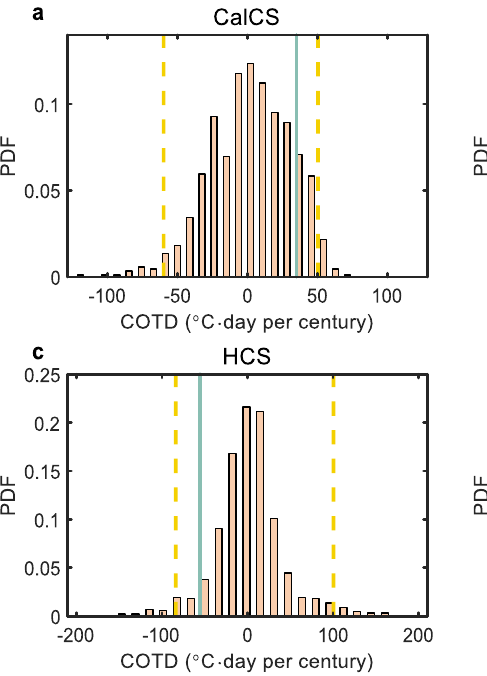
b ), Humboldt current system (HCS, c ) and Benguela current system (BCS, d ) in high-resolution CGCM simulations with the fi xed greenhouse gas concentration. The yellow dashed lines denote the 2.5% and 97.5% percentiles. The green lines denote the COTD of MHW stress during 1982 – 2021 in the observation. Regions used for spatial average are delineated by the green boxes in Fig. 1a –